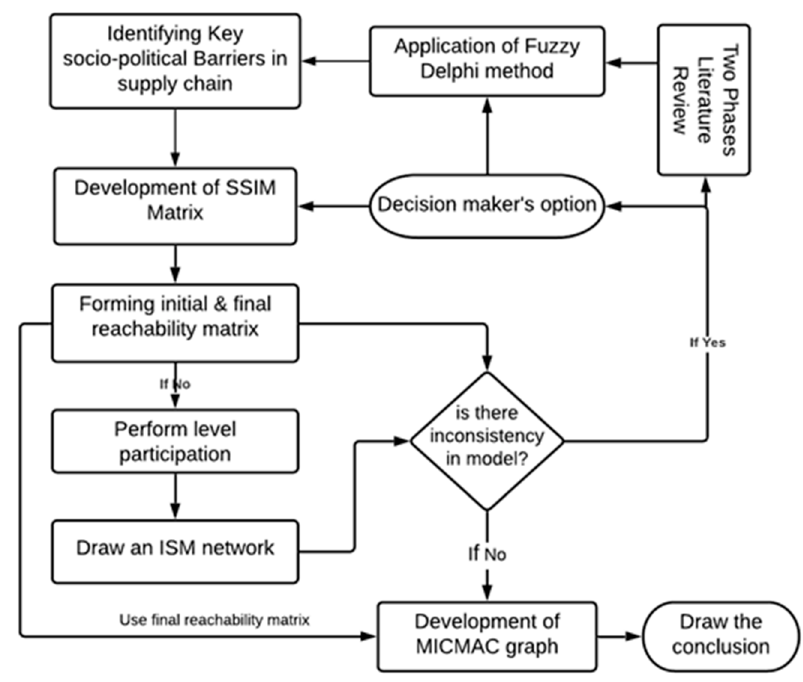
Figure 1. Flow of Figure 1. Flow of ISM.